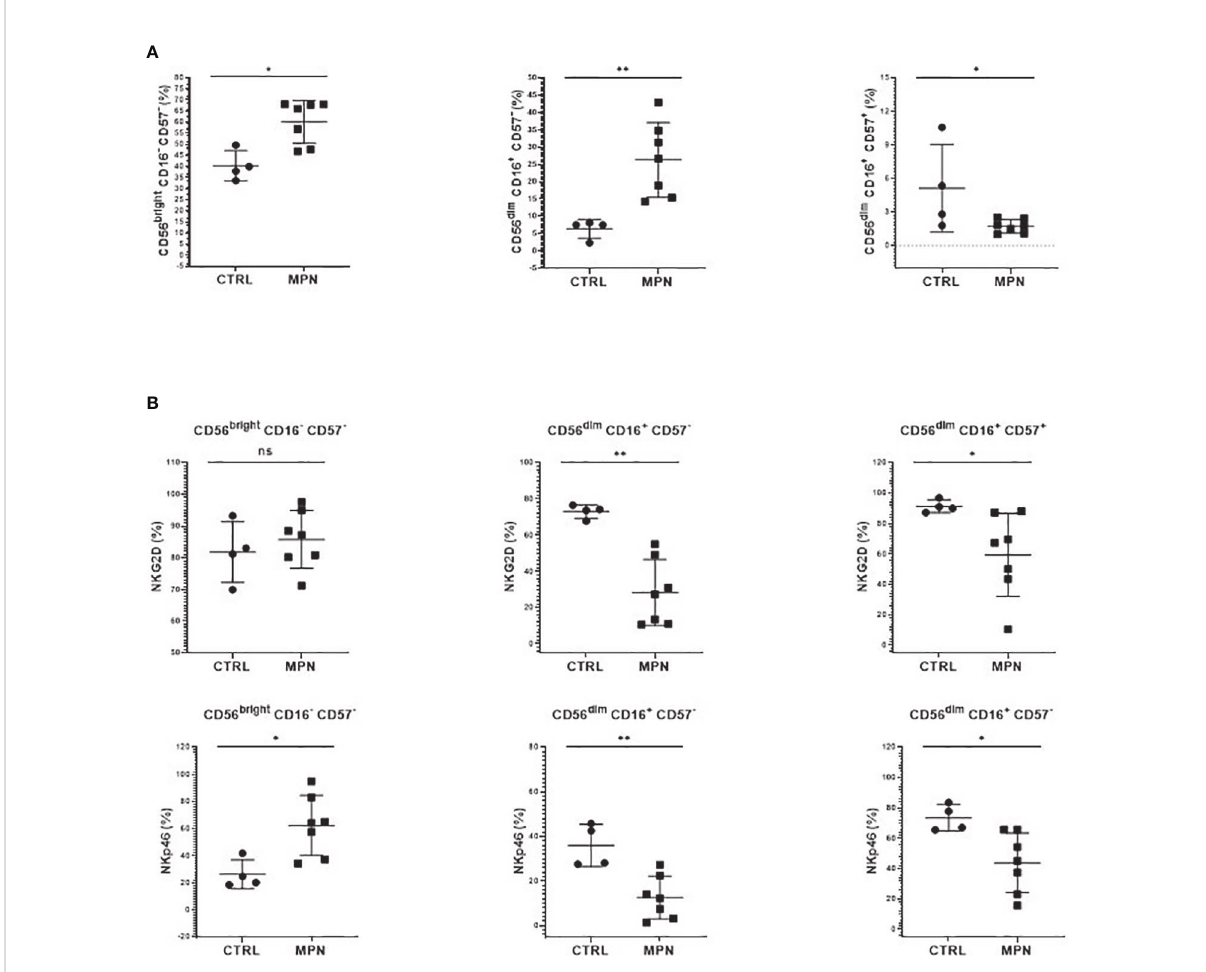
FIGURE 4 NK cells from MPN patients are phenotypically immature. The frequency of (A) immature (CD56 bright CD16 − CD57 − ), intermediate (CD56 dim CD16 + CD57 − ), and mature (CD56 dim CD16 + CD57 + ) NK cells; (B) NK-cell activation (NKG2D, NKp46) receptors by CD57 maturation subsets. CTRL, control (n = 4); MPN, myeloproliferative neoplasms (n = 7). Error bars indicate the mean (± SEM). NS, not signi fi cant (p > 0.05); *p < 0.05; **p < 0.01; Mann – Whitney and Kruskal – Wallis